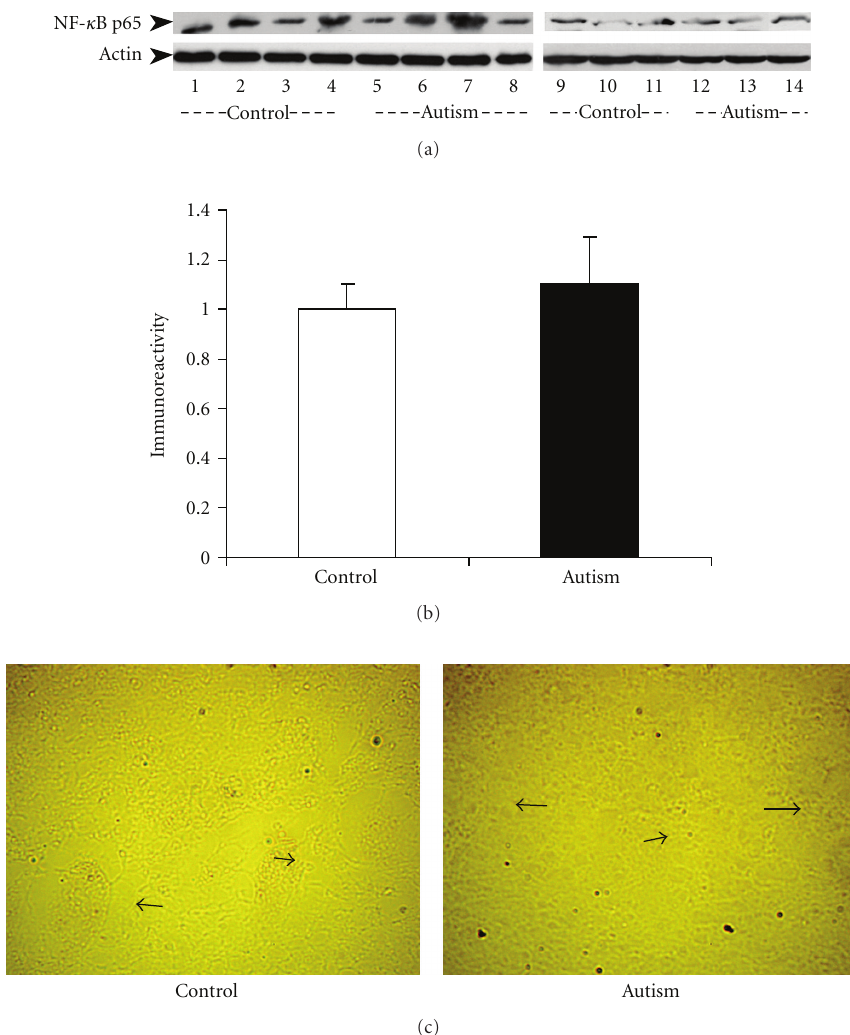
Figure 3: NF- κ B p65 protein expression in the cerebellum of autistic subjects. (a) Two independent western blot studies on cerebellar homogenates using NF- κ B p65 antibody (dilution 1 :500). Lanes 1–4 and 9–11 represent the controls, and lanes 5–8 and 12–14 represent the autistic subjects. The lower panel shows actin bands (MW: 48kd), and the upper panel shows the NF- κ B p65 protein bands (MW: 65 kd). (b) The blots shown in (a) were quantitated after being normalized by actin. Data are shown as mean ± SE. White bars represent controls, and black bars represent autistic subjects. (c) Immunostaining of cerebellar sections using NF- κ B p65 antibody (dilution 1:150). Very faint expression of NF- κ B p65 (red color) was detected in the neural cells (indicated by arrows) in autistic cerebellar (right panel), as well as in the matched controls (left panel). The image is viewed under high power